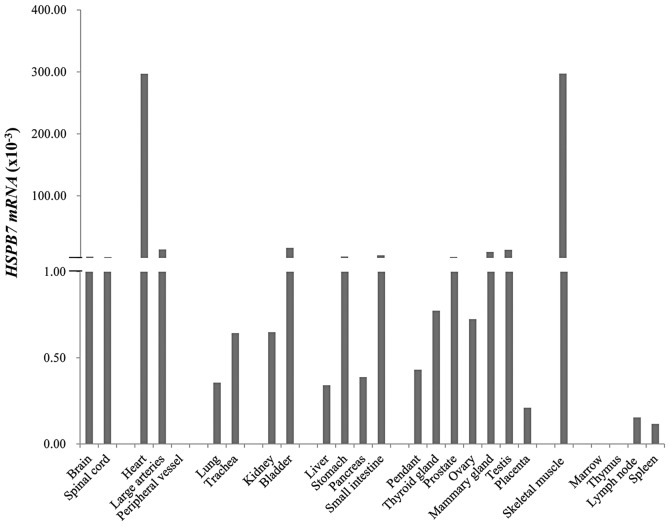
HSPB7 expression levels in normal tissues. qPCR analysis of HSPB7 was performed using mRNA isolated from 25 different normal tissues. B2M was used for normalization of expression levels.